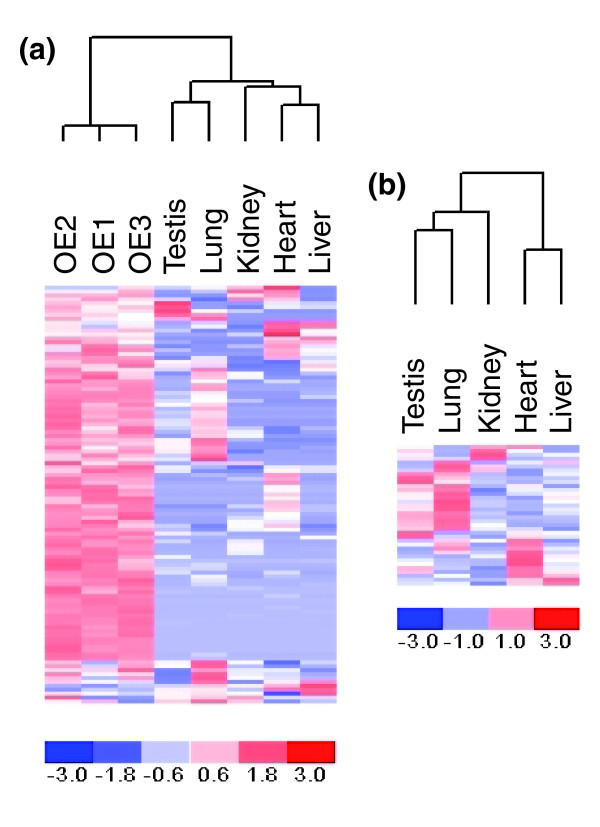
Expression profile of human OR genes across tissues. The log transformed detection P values for OR genes in all tissues (from Additional data file 1) were standardized to have mean 0 and standard deviation 1 and are color coded (red and blue shades indicate values above and below the mean, respectively). The dendrograms on top of each panel illustrate the clustering (by hierarchical clustering in dchip [48]) of tissue samples based on the profile of OR gene expression. (a) All 578 predicted OR genes are included in a comparison between olfactory epithelium (OE) and the non-olfactory tissues (see Materials and methods). (b) Shown are the data for only the 147 OR genes with significantly elevated expression in non-olfactory tissues.